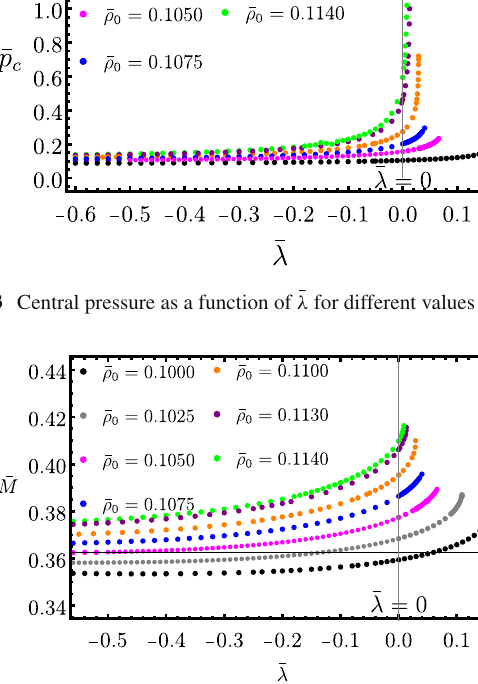
Fig. 2 ¯ p c as a function of ¯ ρ 0 , for various values of ¯ λ > 0 (upper panel) and ¯ λ < 0 (lower panel)